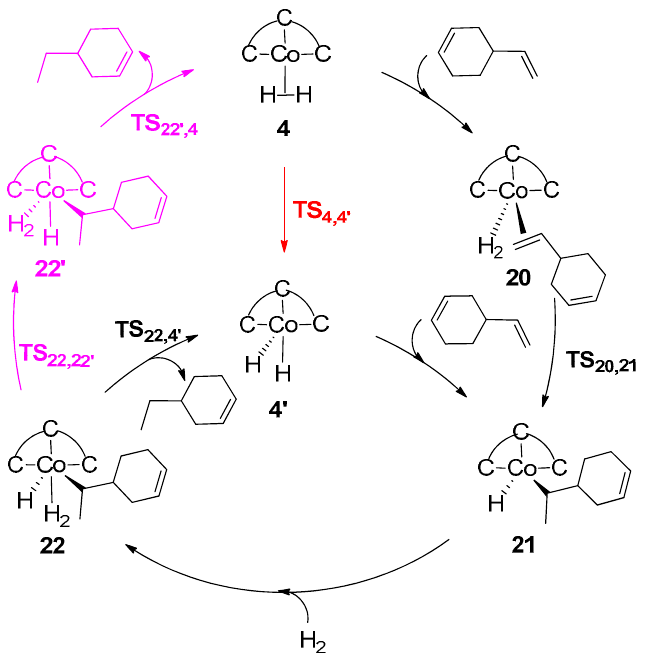
Scheme 7. Proposed catalytic cycle for the hydrogenation of 4-vinylcyclohex-1-ene to 4-ethylcyclohex-1-ene catalyzed by ( Mes CCC)Co complexes.